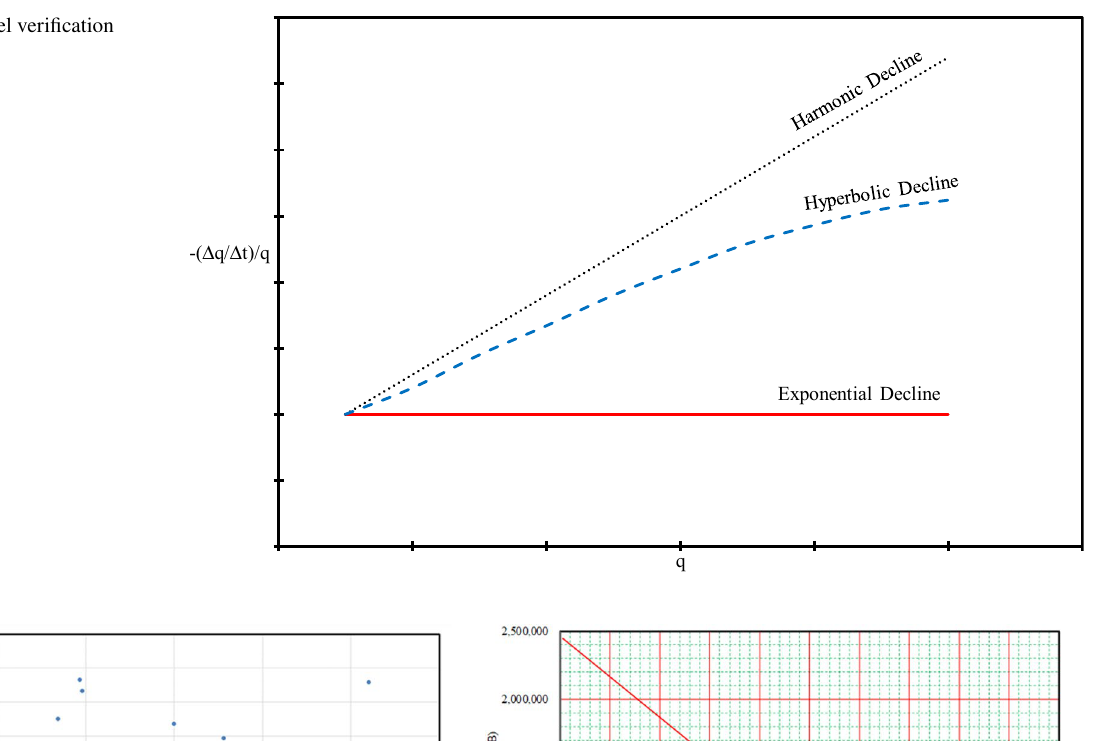
Fig. 1 DCA model verification (Guo et al. 2007)